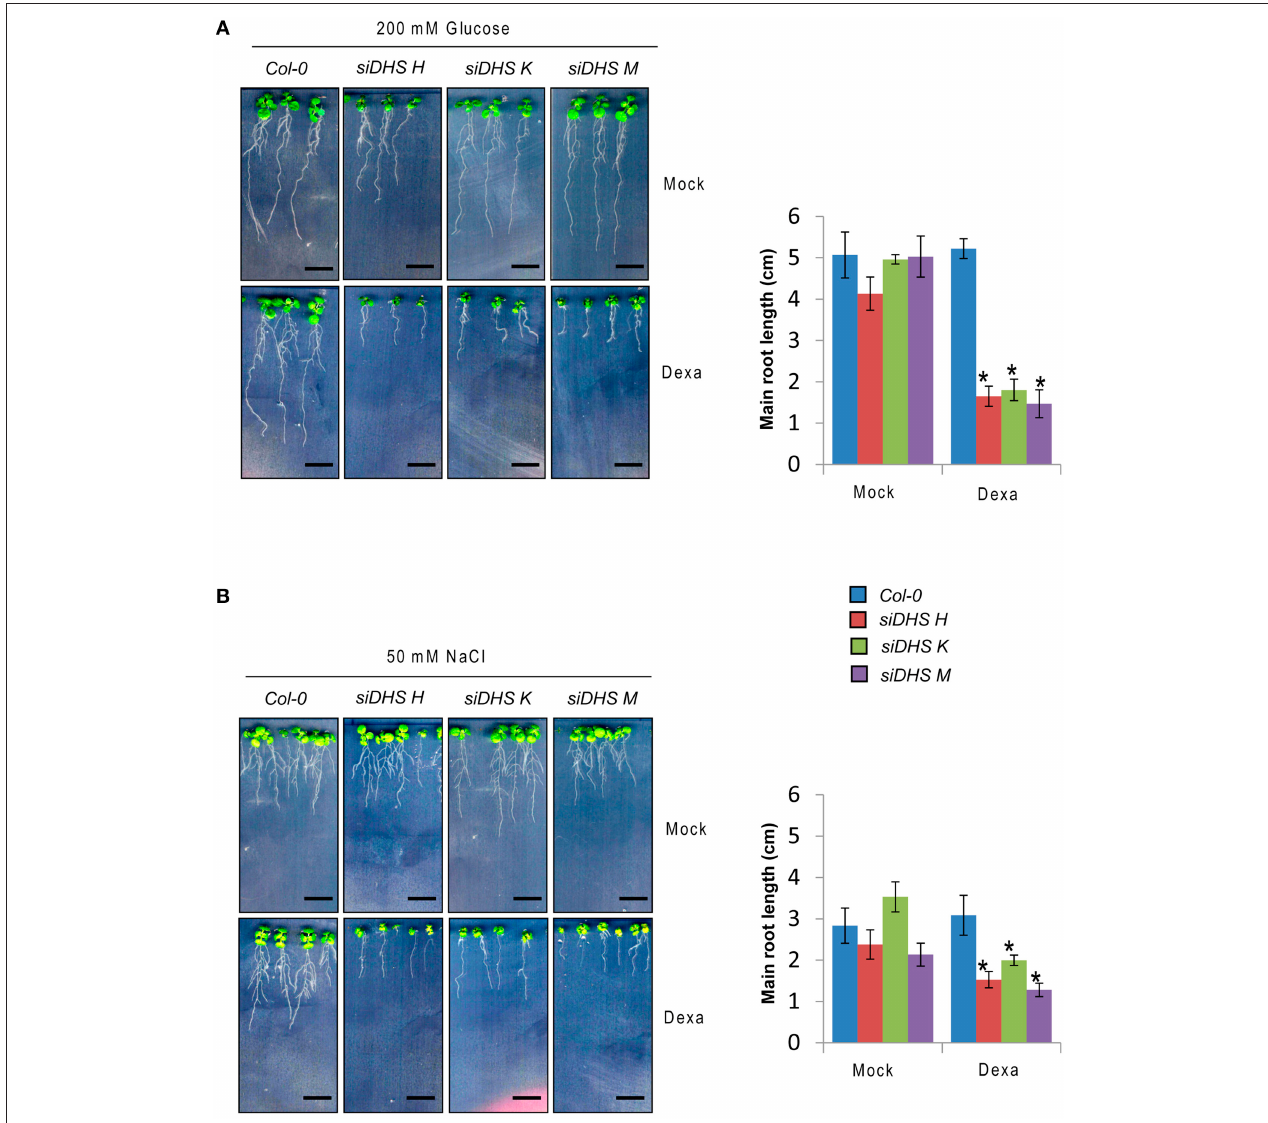
FIGURE 5 | DHS silencing leads to glucose and NaCl hypersensitivity. (A) 4-day-old plants grown in vitro under long-day conditions with or without dexamethasone were transferred to medium with 200mM D-glucose for 10 additional days when pictures were taken (left) and the growth of the main root was measured (right). (B) Plants were sown directly on medium with or without 50mM NaCl in the presence or absence of dexamethasone, and the root growth was recorded (left) and measured (right) at the age of 14-day-old plants. In all the cases the length of the main root of at least 5 individual plants of each transgenic line and treatment was quantified with ImageJ. Asterisks indicate significant differences ( p < 0.05 ) with respect to mock-treated plants of the same genotype. Scale bars represent